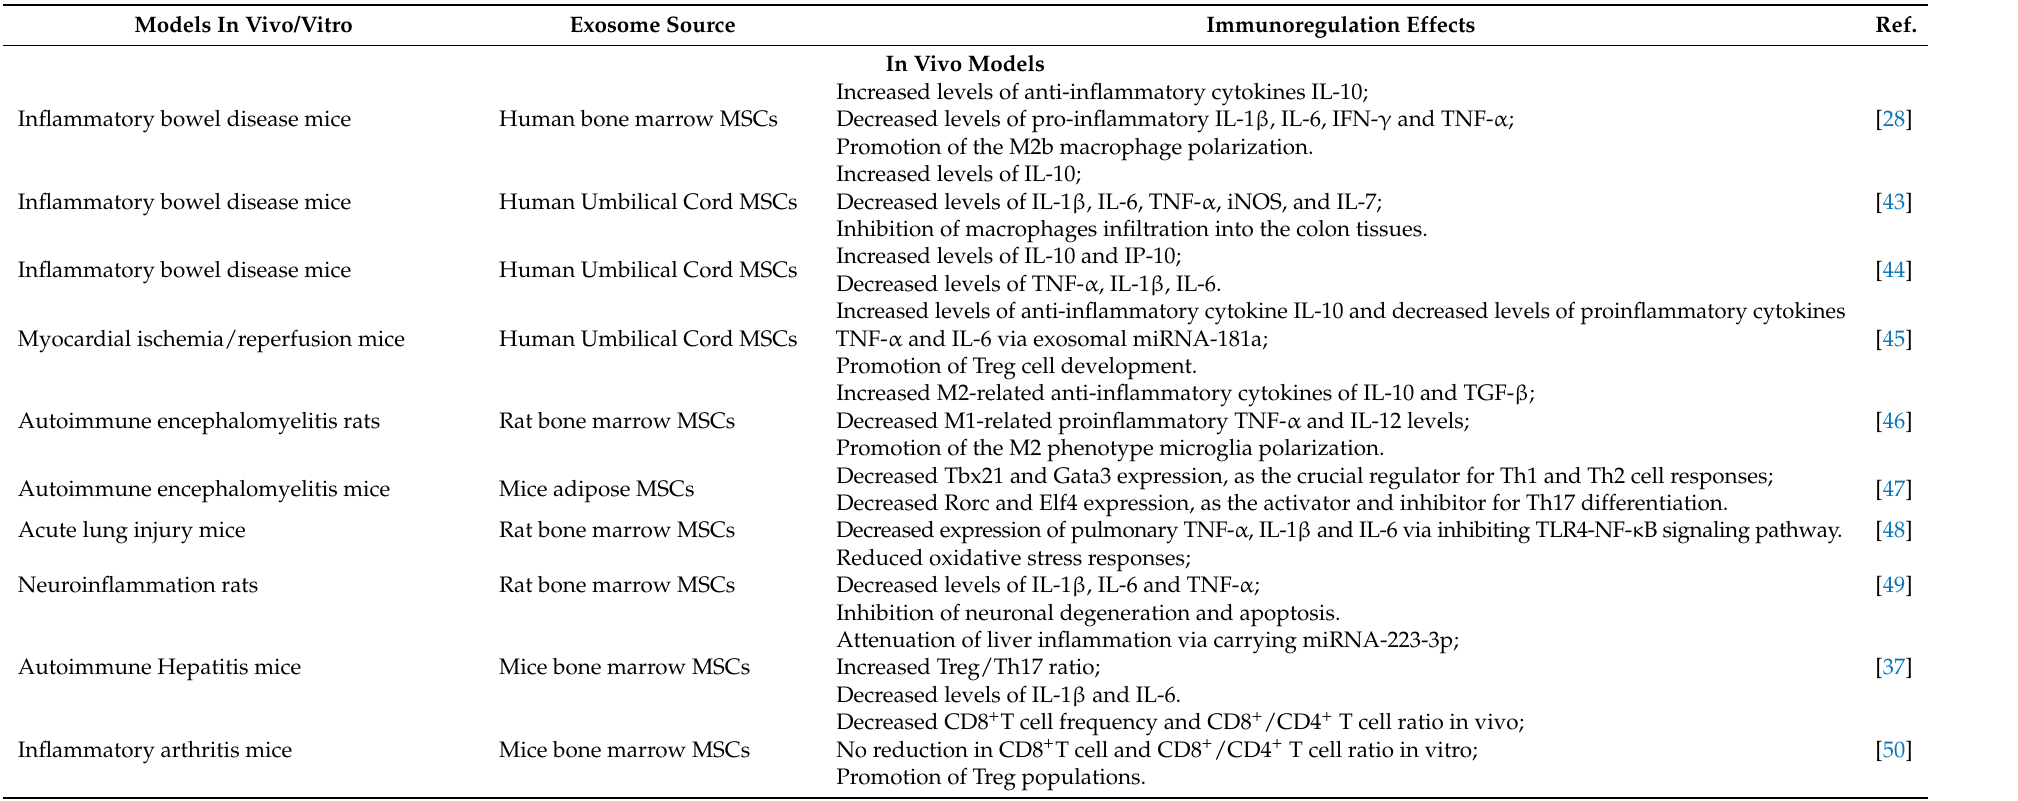
Table 1. Mesenchymal Stem Cell (MSC) Exosomes Perform Immunoregulation